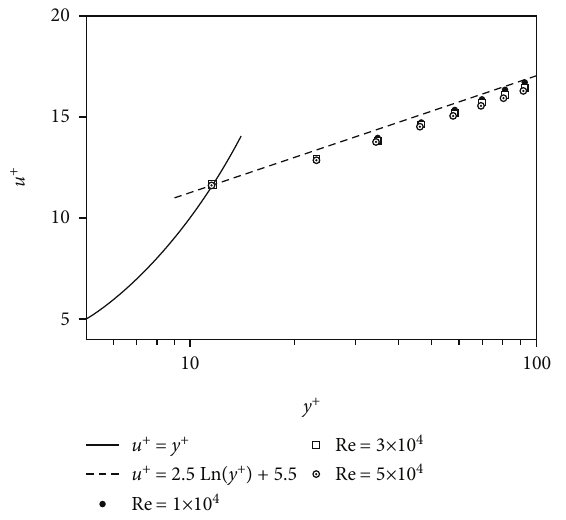
Figure 4: Velocity pro fi le for di ff erent Reynolds ’ numbers.